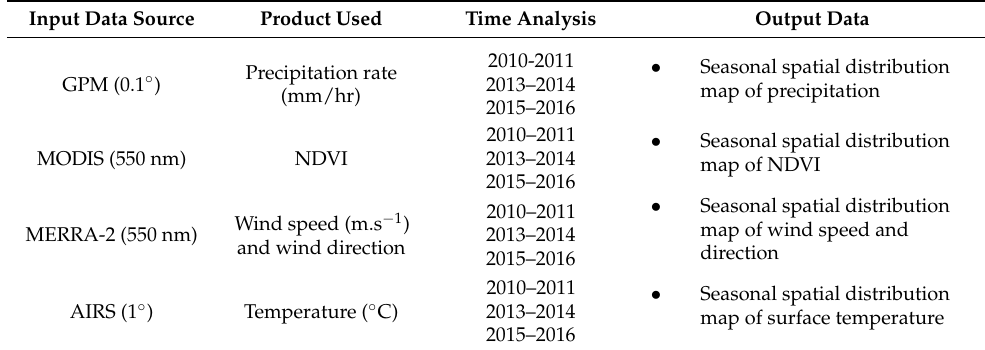
Table 1. Dataset used to in this